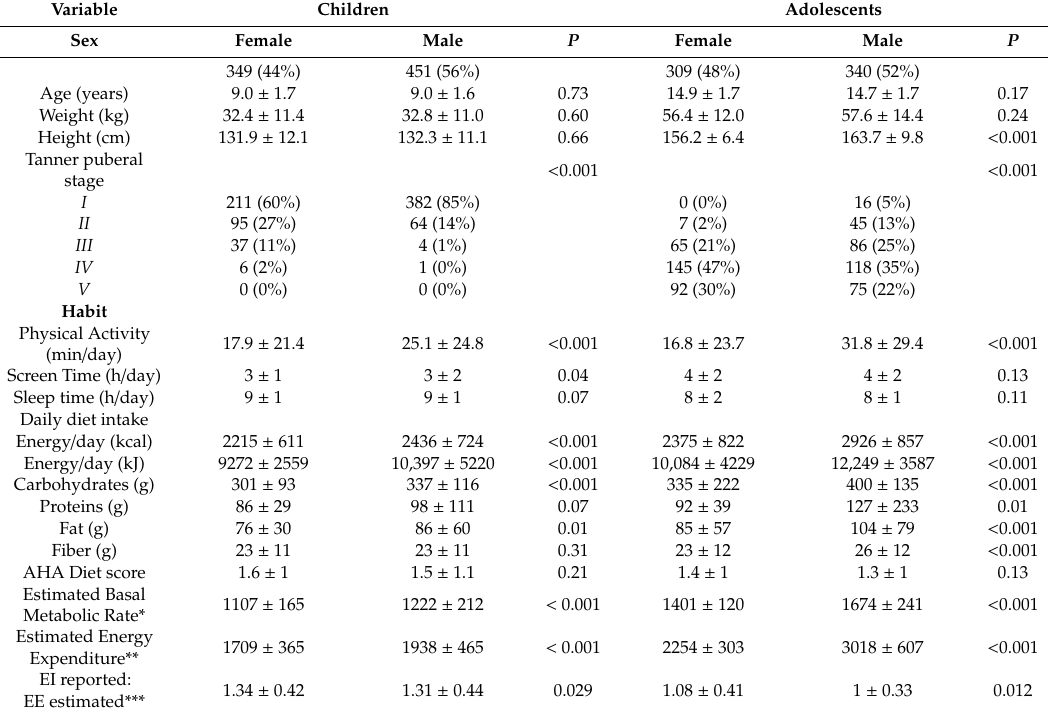
Table 1. Characteristics and obesogenic lifestyle (OL) components in Mexican children and